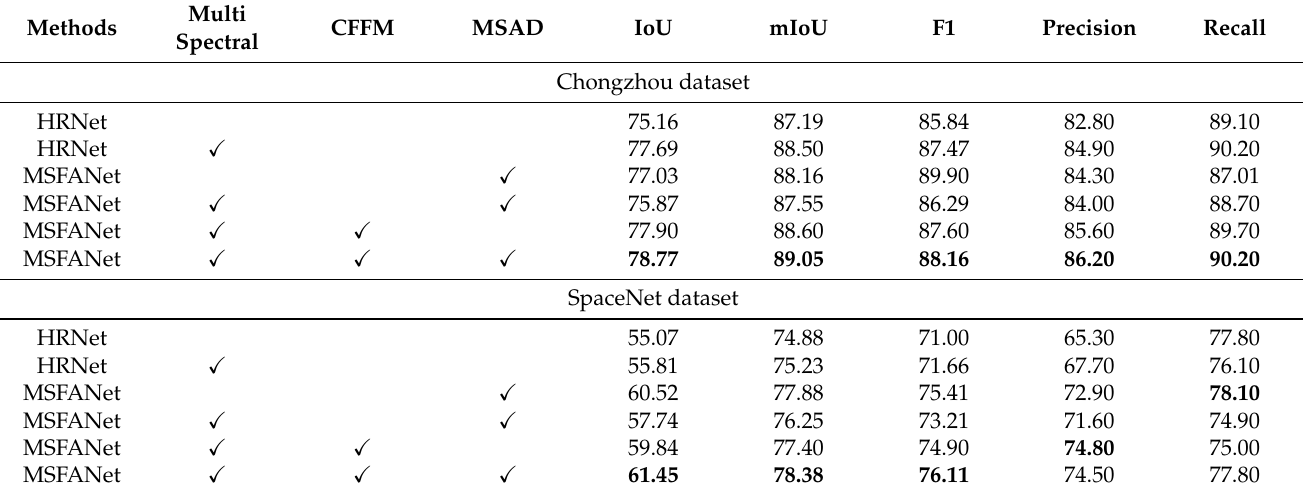
Table 4. Ablation study results obtained by IoU (%), mIoU (%), F1-score (%), precision (%) and recall (%) on two datasets. Best results are shown in